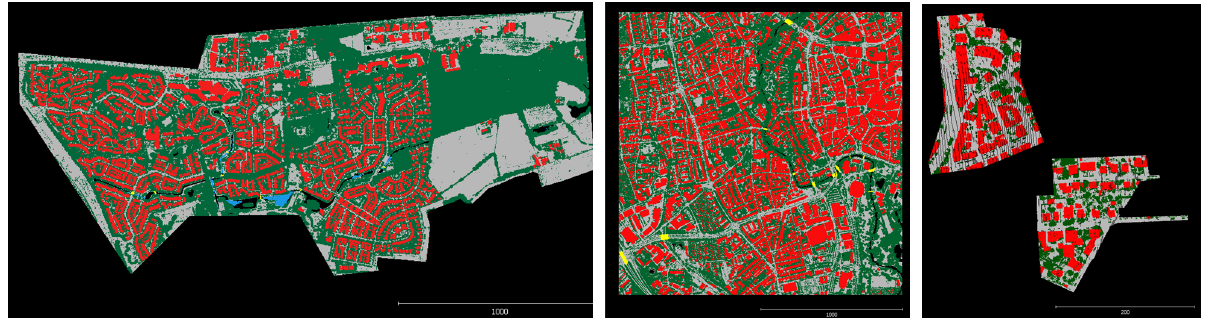
Figure 3. Reference classes for the AHN3 test set (left), Brunswick (middle) and Vaihingen (right). Grey: ground; green: non-ground; red: building; blue: water; yellow: bridge.